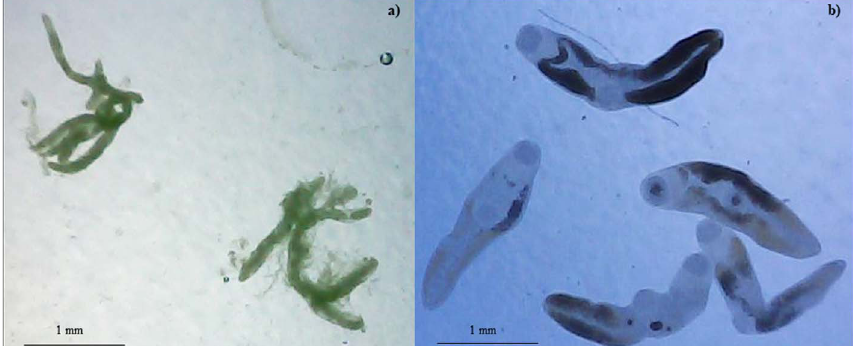
Figure 1. (a) Sporocysts and (b) metacercariae of Brachylaima found in Cornu aspersum at sites in France. Sporocysts were only recorded in Arçais, whereas metacercariae occurred in Arçais and